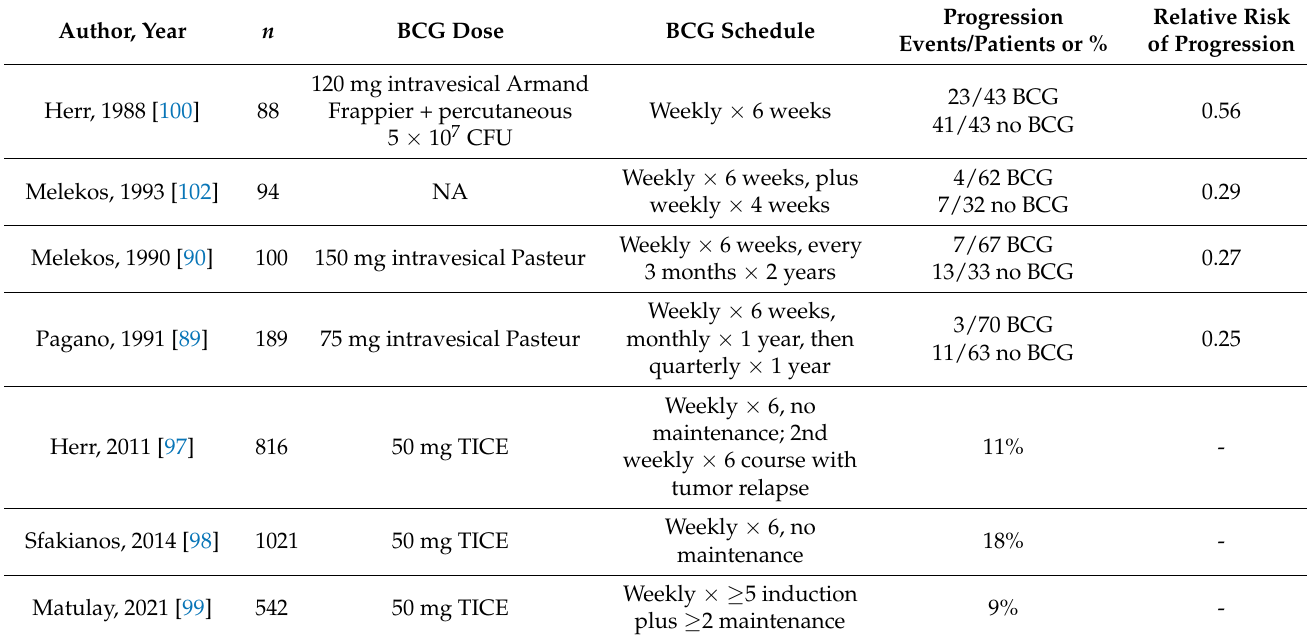
Table 2. Clinical trials assessing progression-free survival after BCG